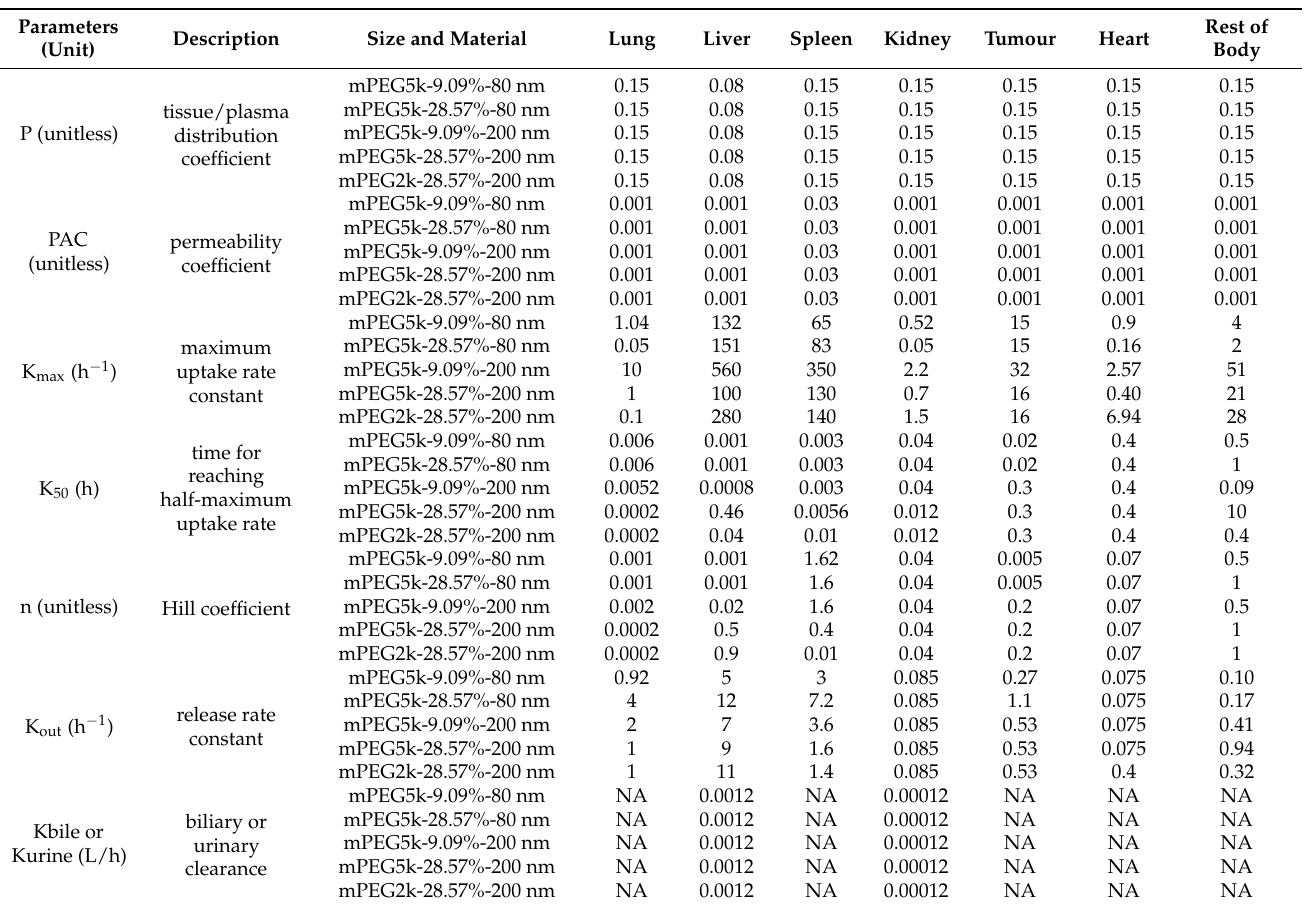
Figure 6. Simulated and experimentally measured concentration–time curves of mPEG2k-28.57%-200 nm NPs in mouse blood and tissues after intravenous injection. Table 2. mPEG-PCL NP-specific descriptions and values of parameters in the PCs-PBPK